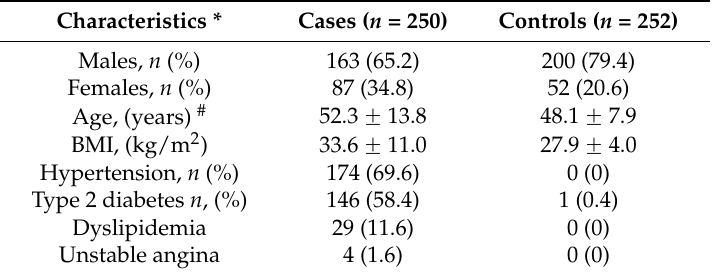
Table 1. Clinical characteristics of coronary artery disease (CAD) cases and controls in a population from Eastern Province, Saudi